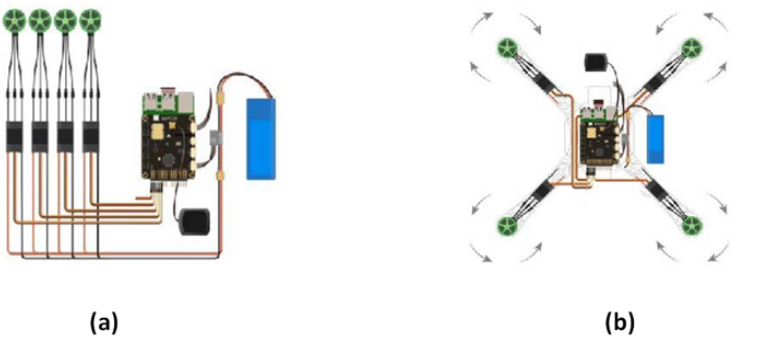
Figure 10. The assembly of the VAGADRONE components ( a ) the wiring diagram ( b ) the components with the chassis.